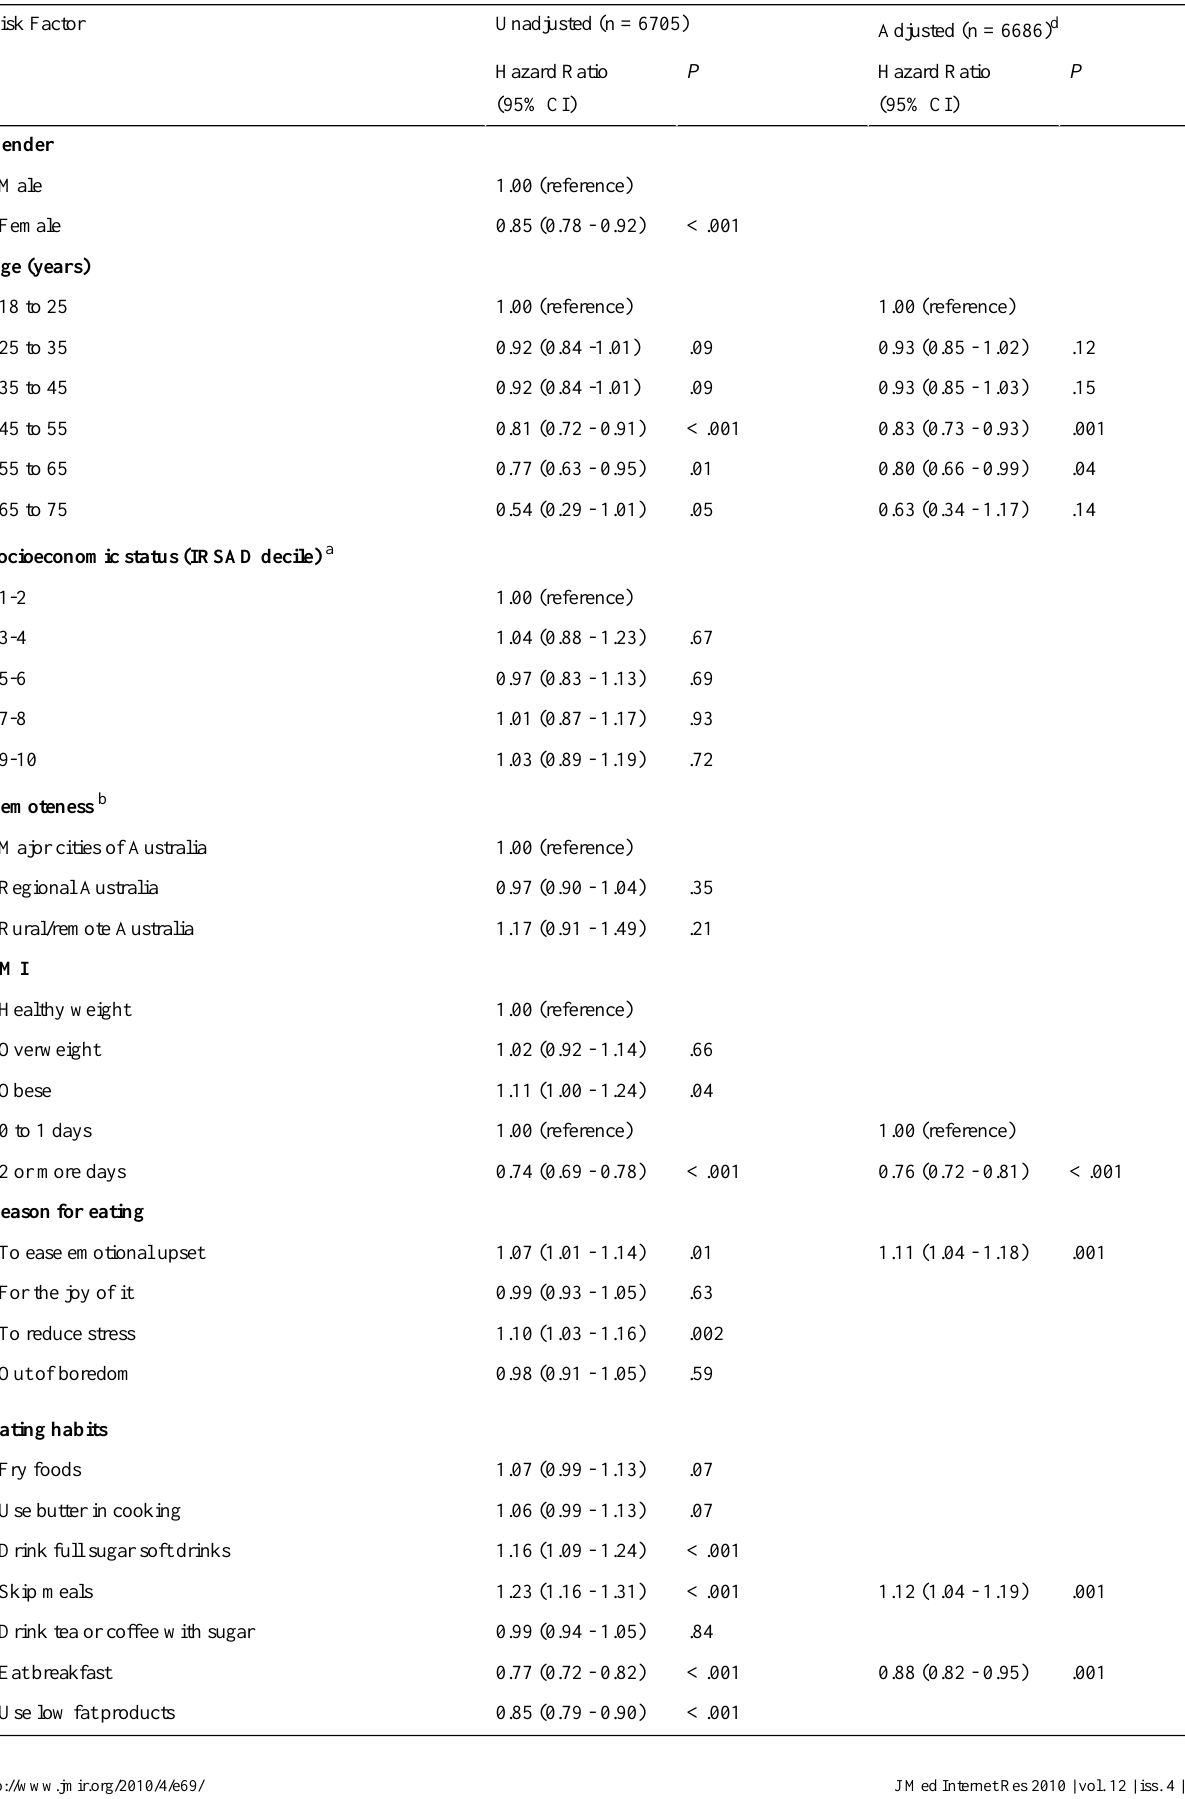
Table 2. Risk of nonusage attrition for 12 week